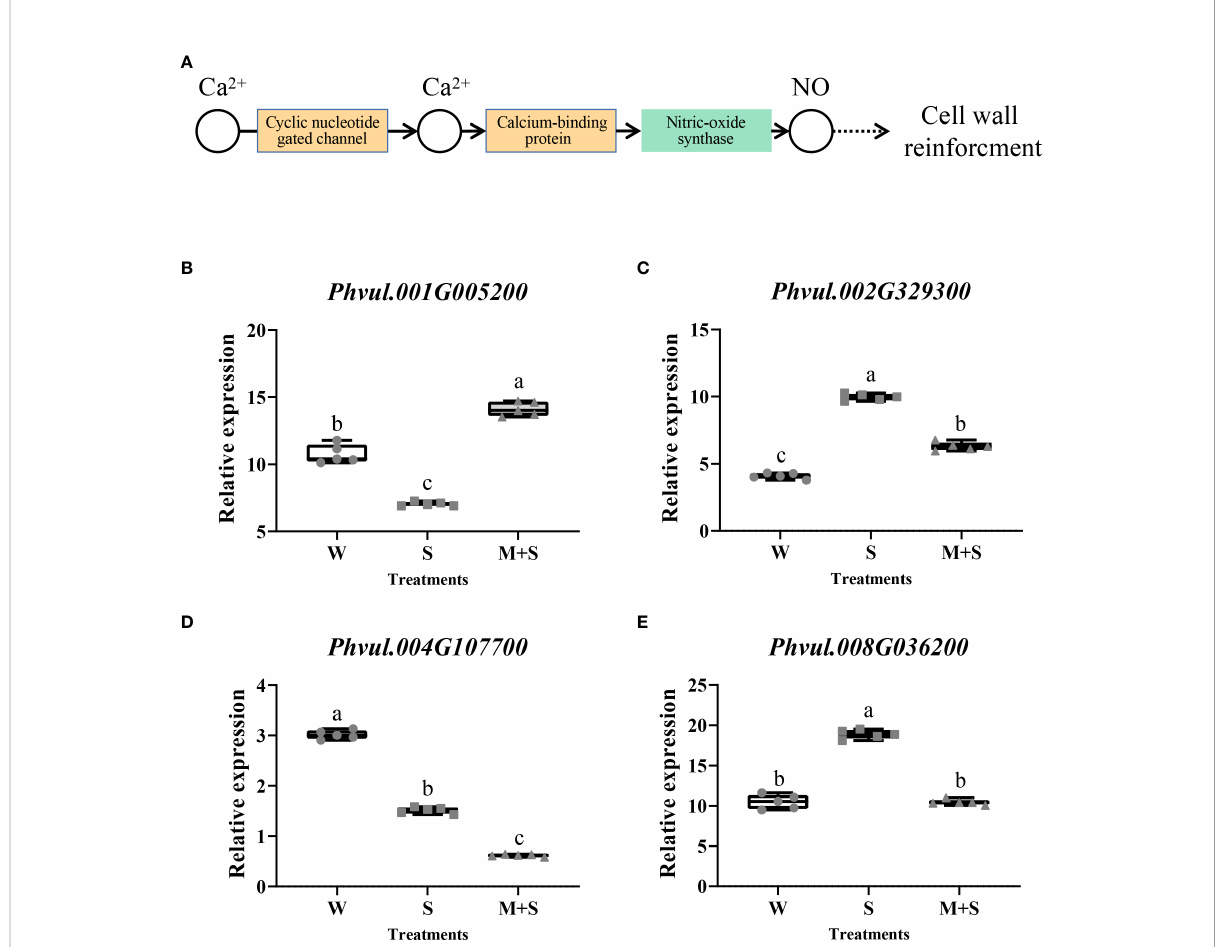
FIGURE 3 Analysis of the “ Plant-pathogen interaction (pvu04626) ” pathway and its related genes enriched in the KEGG pathway of the common bean under W (water: CK), S (salt), and M+S (melatonin with salt) treatments. Different lowercase letters in the same column indicate signi fi cant differences between the treatments (P<0.05). (A) “ Plant-pathogen interaction ’’ pathway; the brown part represents the enriched DEGs points. (B) Expression analysis of Phvul.004G098300 . (C) Expression analysis of Phvul.007G002400 . (D) Expression analysis of Phvul.007G099700 . (E) Expression analysis of Phvul.008G003200